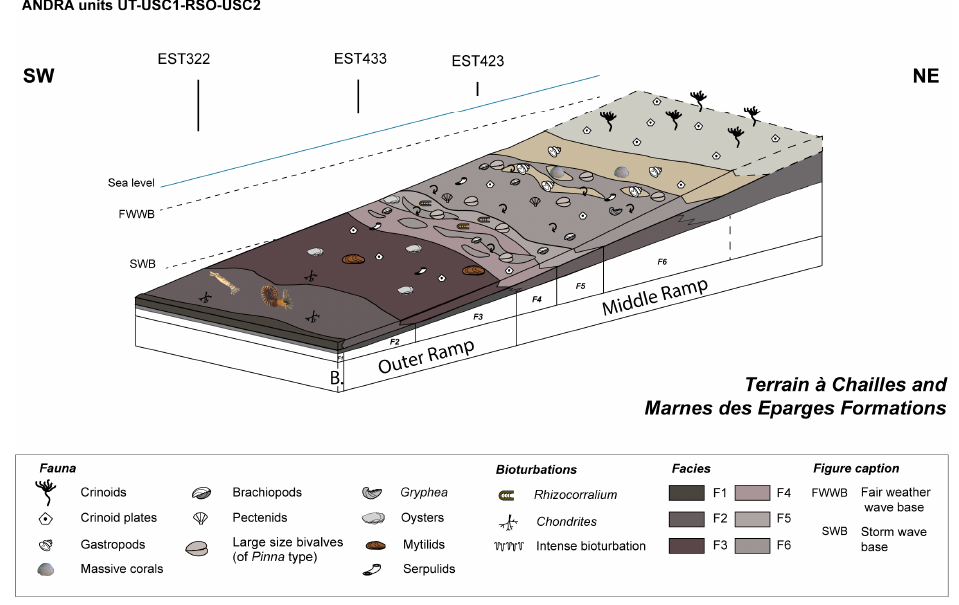
Figure 6. Depositional model of lower and upper Oxfordian deposits ( cordatum to plicatilis zones). Depositional environments show a progressive deepening towards the SO, typifying a homoclinal ramp morphology. Numbers F1 – F6 indicate the five facies association recognised; B. stands for Ba- sin. All investigated wells show that a lithological transition occurs within the “Terrain à Chailles” Formation. In the lower part of the formation, lithofacies show little variation. These are mostly linked to changes in quartz (silt fraction) and carbonate contents and correspond to outer ramp settings. In contrast, the upper part of the “Terrain à Chailles” Formation and the “Marnes des Eparges” Formation show an increased occurrence of cal- careous beds and benthic organisms with a higher diversity in benthic macrofauna. Pale- oenvironments thus evolve towards middle ramp settings.